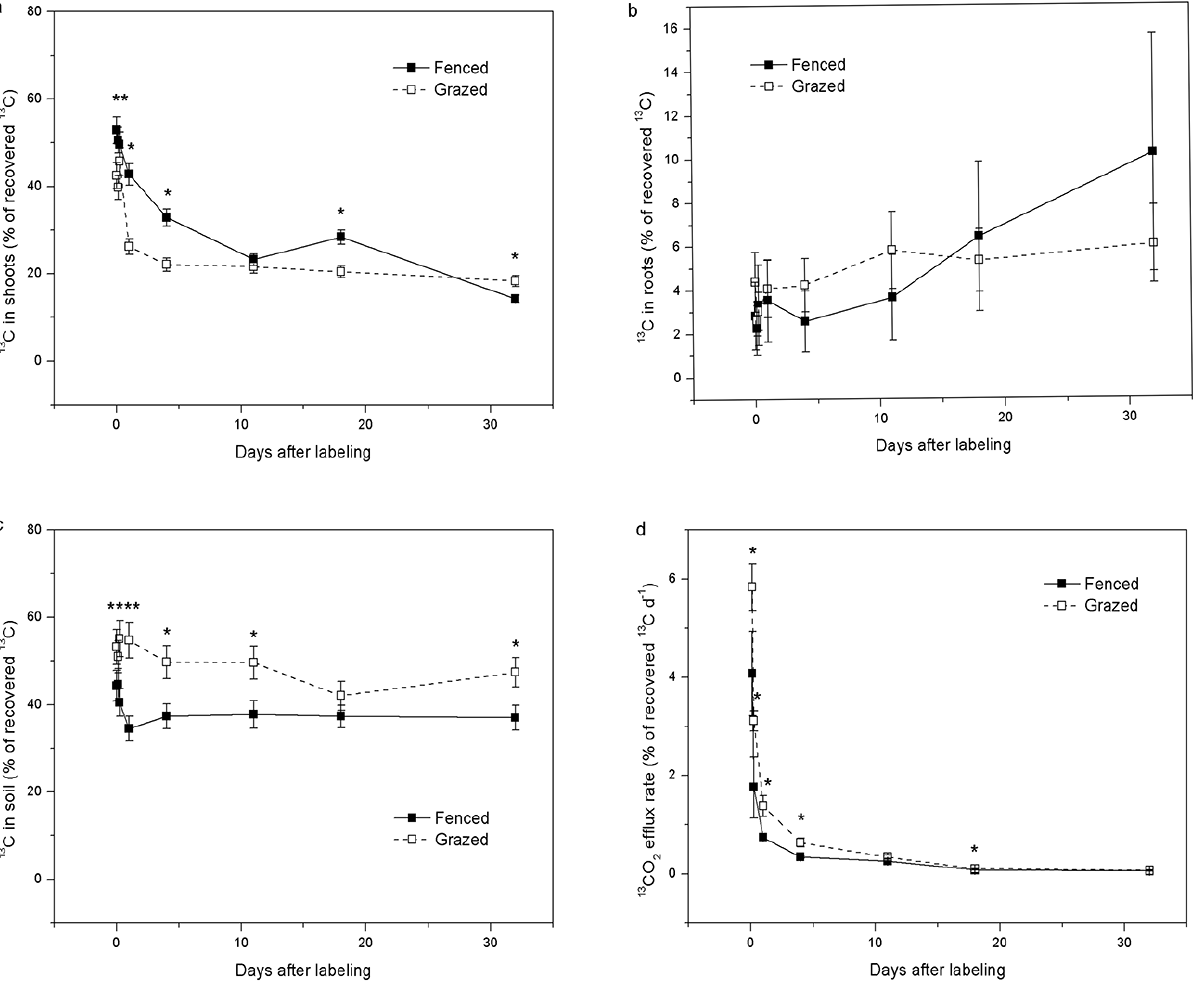
Figure 1. The dynamics of 13 C allocation (percentage of recovered 13 C) in shoots (a) , roots (b) , and soil (c) in the fenced and control grazed meadows during the 32-day chase period. The last figure shows the dynamics of the 13 CO 2 efflux rate (percentage of recovered 13 Cd − 1 ) by soil respiration (d) during the chase period. ∗ Indicates significant differences at P < 0 . 05 between the fenced and grazed meadows for each time step. Data are means ± standard deviation ( n =